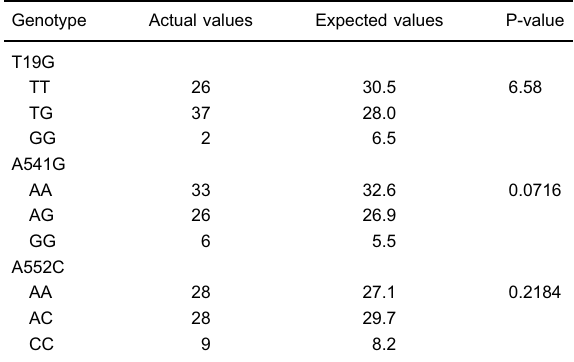
Table 1. Hardy-Weinberg equilibrium test for UGT1A6 gene. Genotype